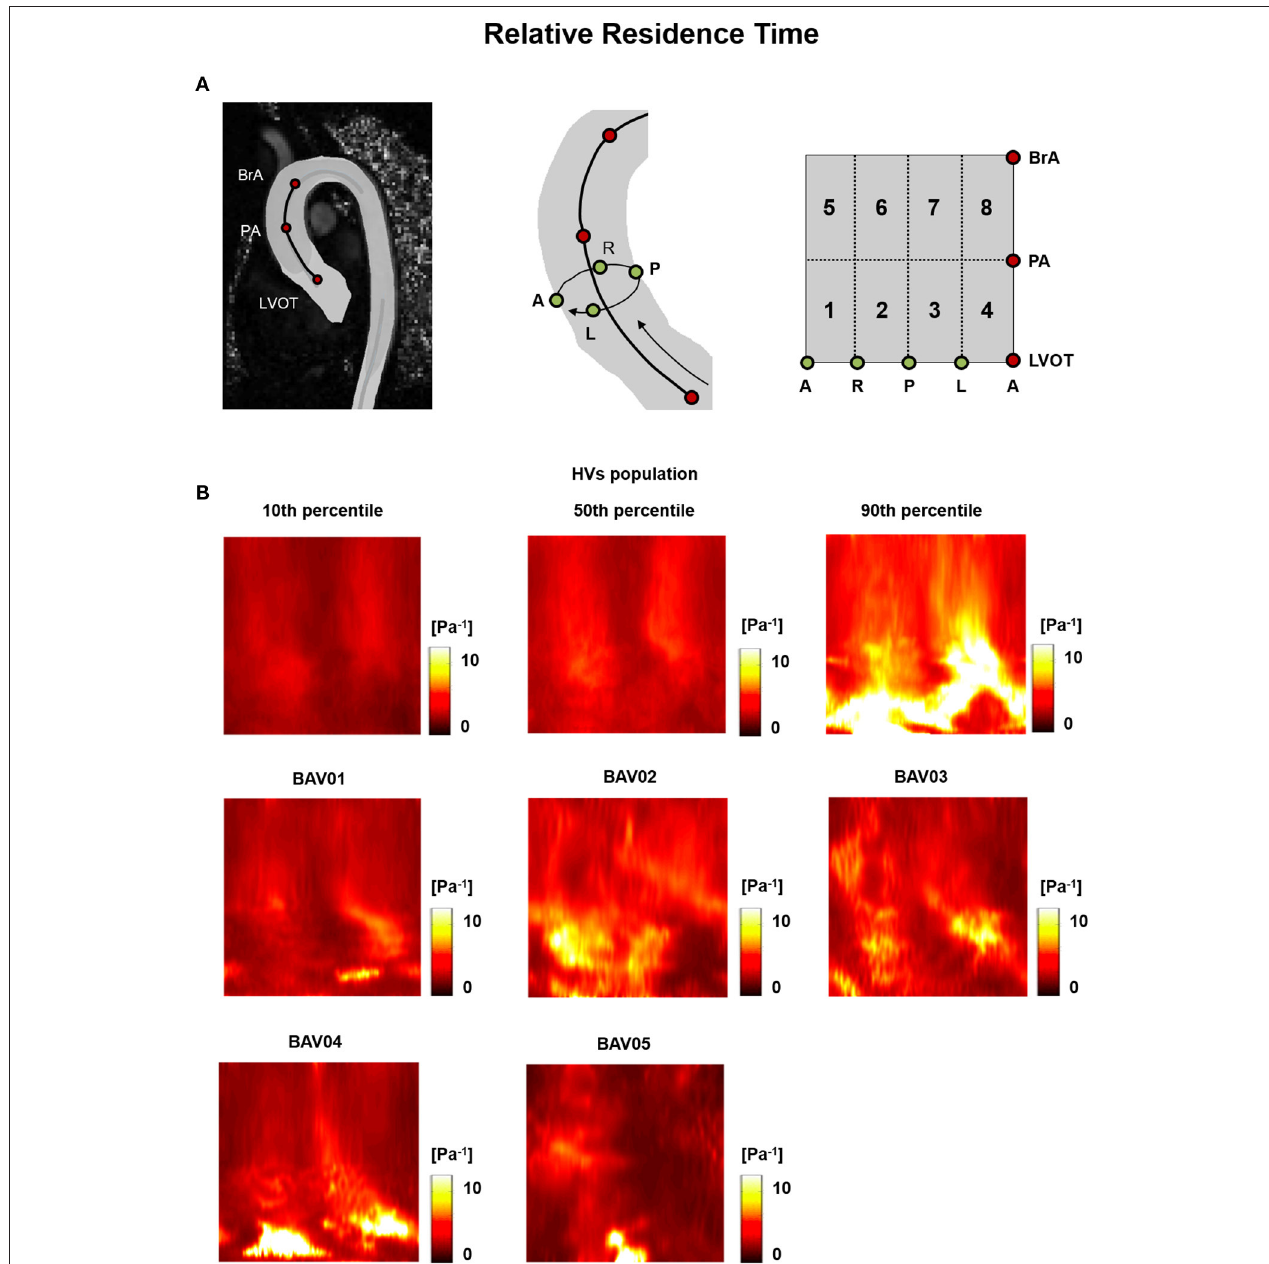
FIGURE 7 | (A) The 2D template detailed in Figure 3 is reported for the sake of clarity. (B) Relative Residence Time (RRT) heat maps for HVs (represented as 10th, 50th, and 90th percentiles) and for each BAV patient obtained through time-averaging over the systolic phase.